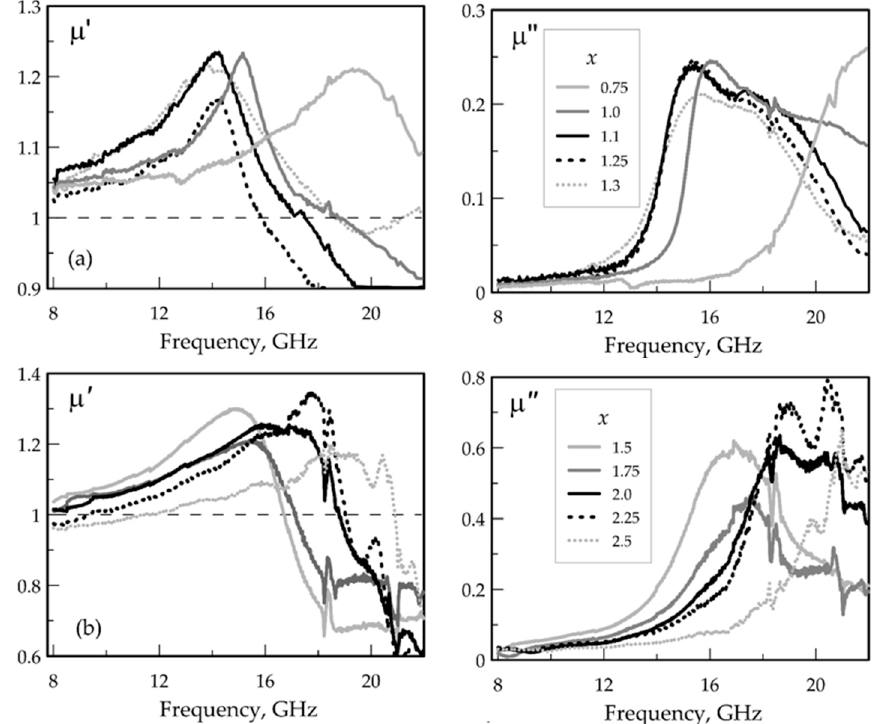
Figure 7. The measured frequency dependence of permeability for the composite samples of BaFe 12 − x Ti x O 19 : ( a ) x from 0.75 to 1.3, the volume fraction of the ferrite powder is 20%; ( b ) x from 1.5 to 2.5, the volume fraction of the ferrite powder is 35%.